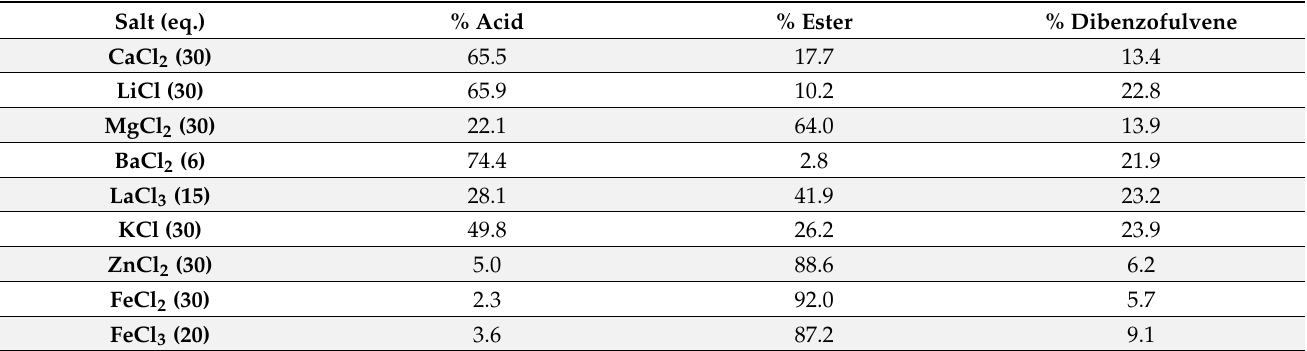
Table 1. Quantitative analysis of Fmoc-Gly-OMe saponification using various salt chlorides